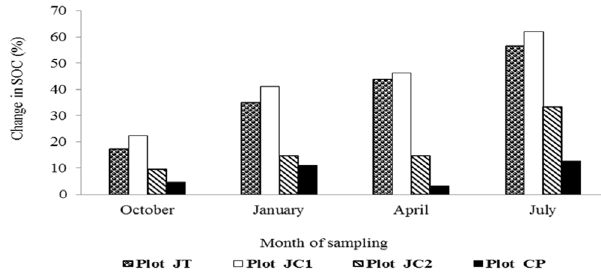
Figure 4. Changes observed in the SOC (%) of the study